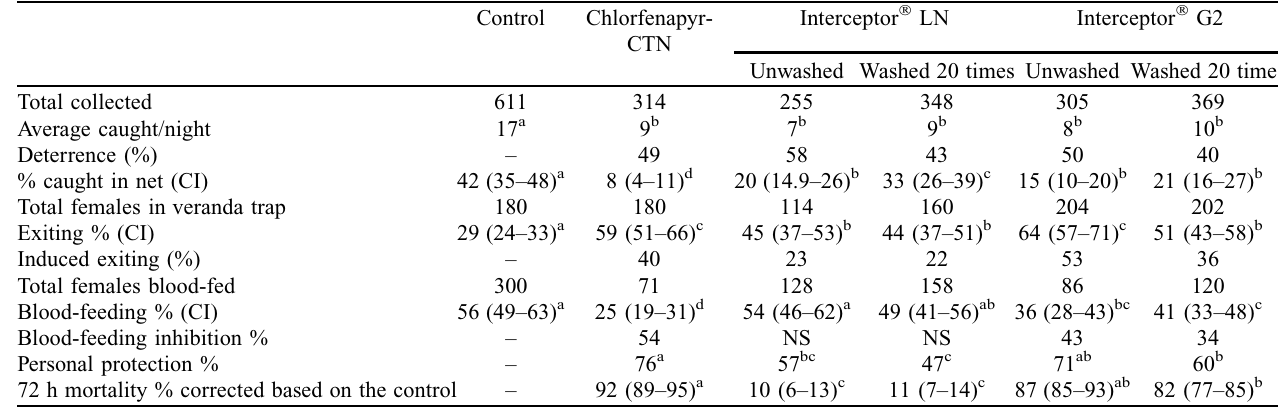
Table 3. Summary results of the experimental hut trial against wild free-flying resistant Anopheles gambiae s.s. mosquito from